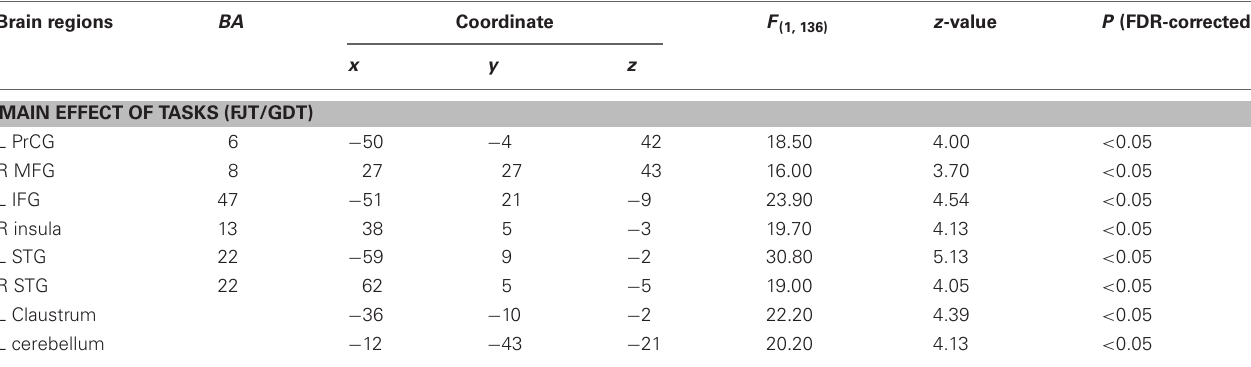
Table 3 | Peak coordinates ( x , y , z ) and their z -values of cerebral activation by full factorial design analysis with task effect (controls and